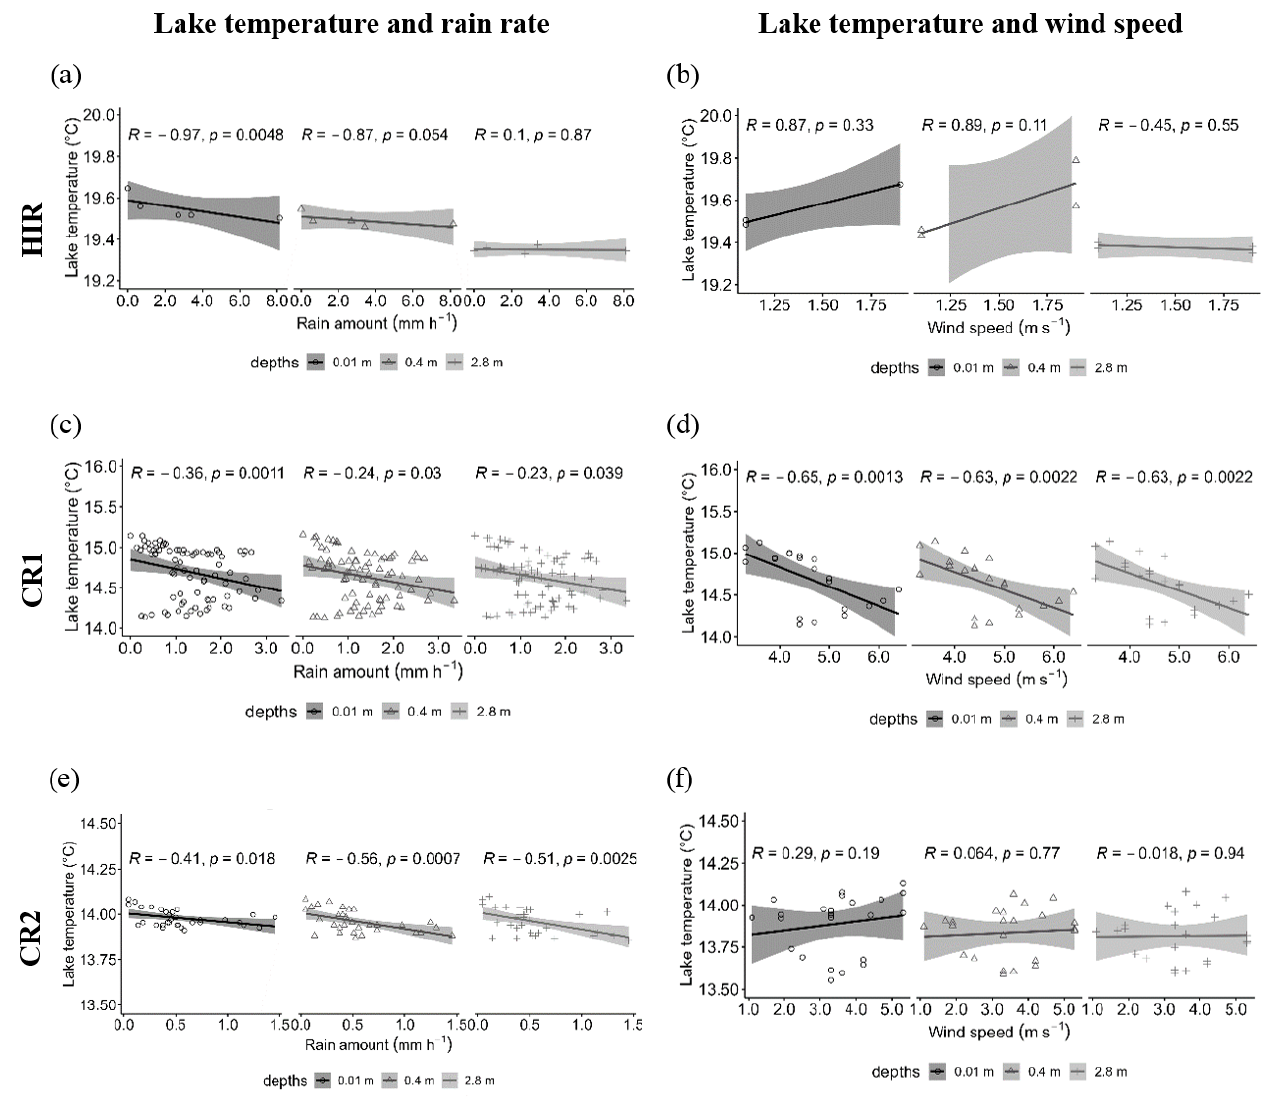
Figure 7. Spearman correlations between the lake temperature and the rain rate with the Parsivel (15min interval) during HIR (a) , CR1 (c , CR2 (e) , and between the lake temperature and the wind speed recorded by the Meteo France weather station (St Genes, 1h intervals) during HIR (b) , CR1 (d) , and CR2 (f)